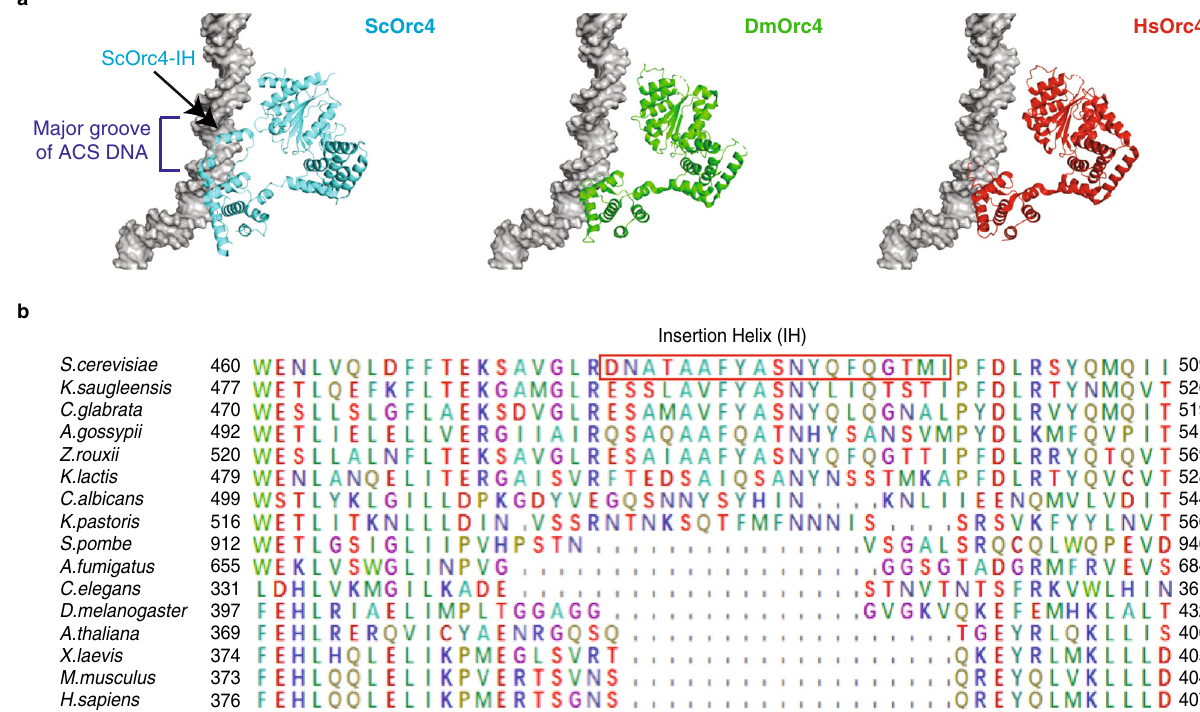
Fig. 1 Orc4-IH is divergent in yeasts and absent in metazoans. a WHDs of Orc4 from S. cerevisiae (Sc), Drosophila melanogaster (Dm), and Homo sapiens (Hs) in contact with DNA. b Multiple protein sequence alignment of Orc4 insertion helixes from indicated